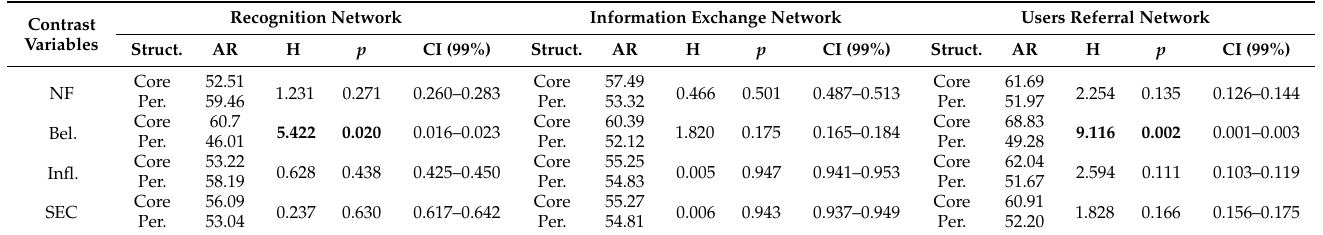
Table 2. Kruskal–Wallis H test applying the Monte Carlo significance criterion with a 99% confidence interval.